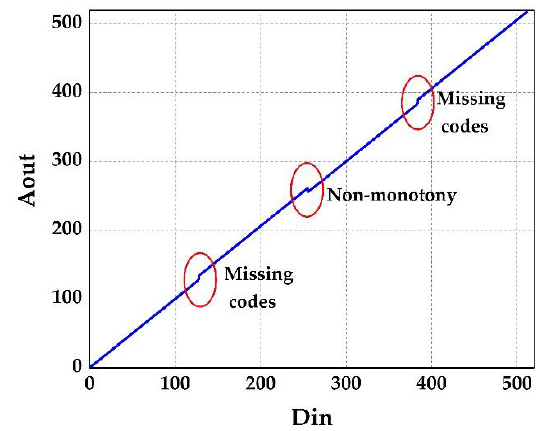
Figure 4. The conversion characteristic of non-ideal 9bit DAC.